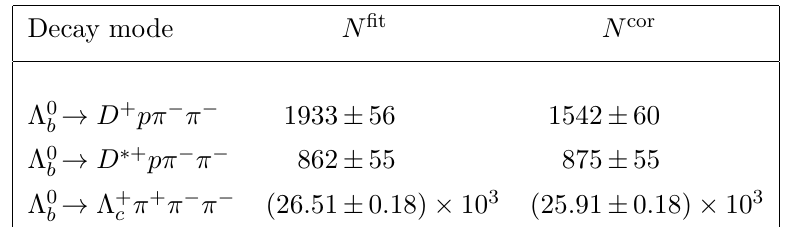
Table 1 . Yields, N fit , for the Λ 0